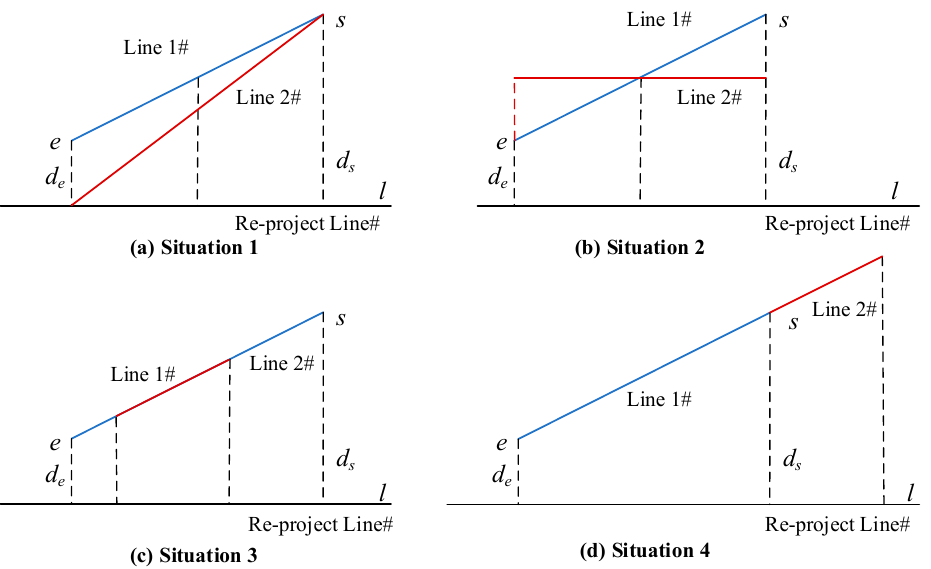
Figure 4. Schematic diagram of the straight ‐ line distance error analysis.